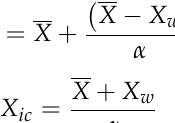
Algorithm 2 Modified Nelder–Mead updating strategy